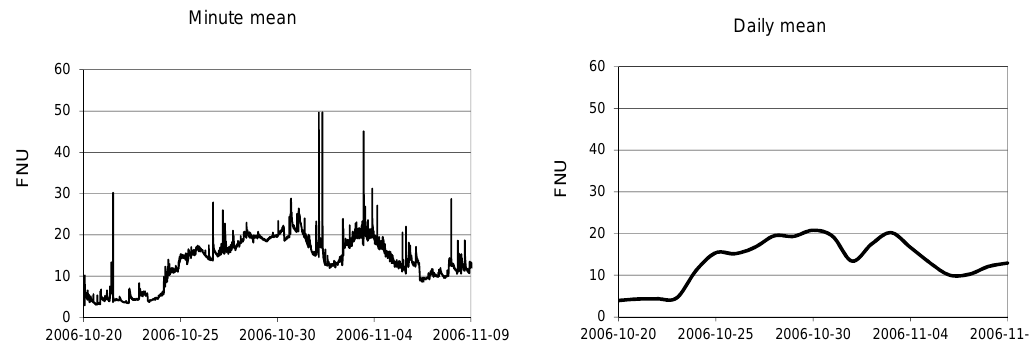
Fig. 4. An example of observed turbidity illustrated with minute mean data (left panel) and daily means data (right panel) for the arbitrary chosen time 29 October–9 November 2006. Ship traffic causes the strong peaks that are seen in the minute mean data (left panel).